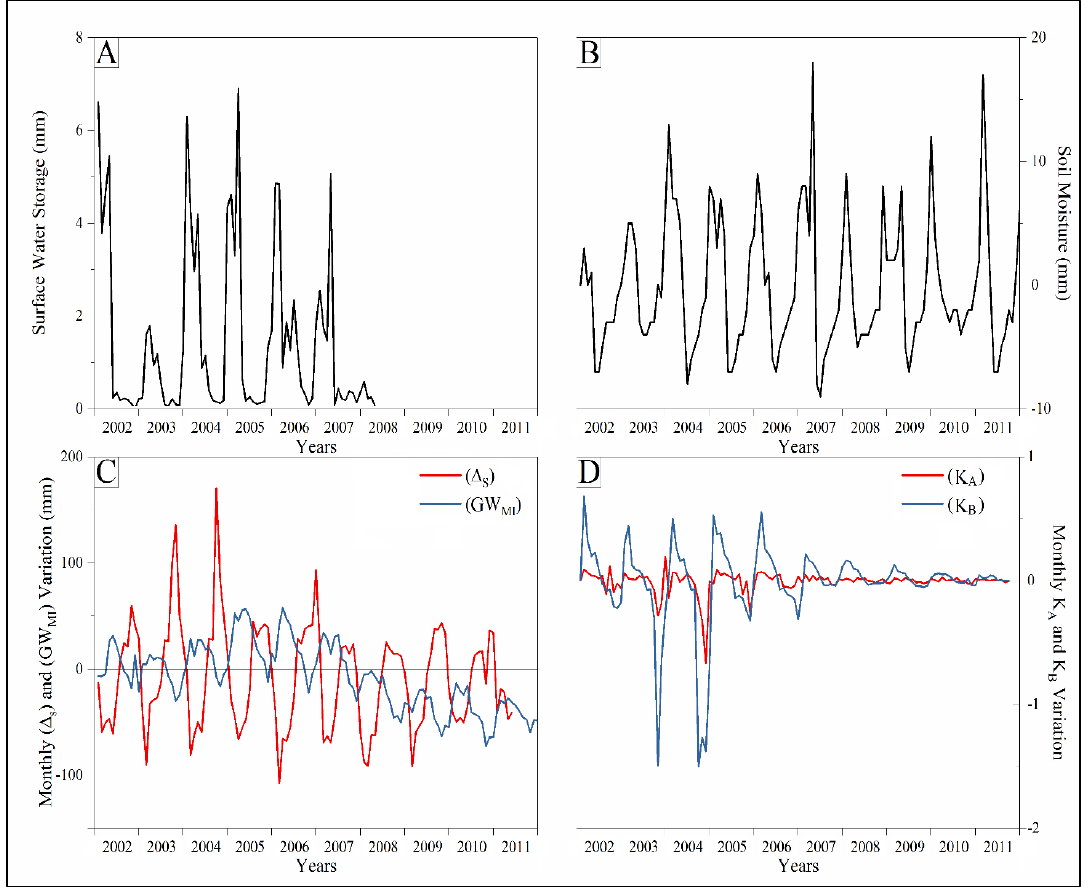
Figure 6. ( A ) Change in measured monthly surface water storage. Y axis: storage variation (mm). ( B ) Monthly soil moisture storage change calculated from GLDAS data. Y axis: moisture variation (mm). ( C ) Measured groundwater level variation ( ∆ S ) compared with groundwater level derived from GRACE data (GW MI ). Y axis: ( ∆ S ) and (GW MI ) variation mm. ( D ) Water mass (K A ) and groundwater level (K B ) fluctuation with respect to monthly net precipitation change in the Bakhtegan catchment.